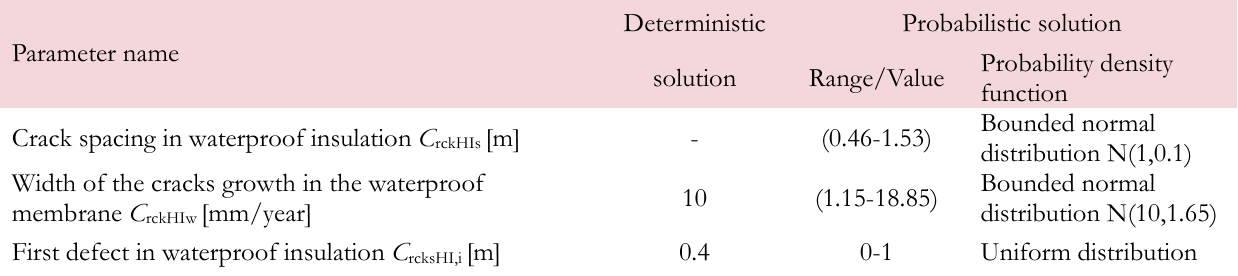
Table 2: The modification of random input variables and deterministic input parameters for ordinary concrete and a reinforced concrete bridge deck with a crack under damaged waterproof insulation (P2B - unprotected steel reinforcement, P2E - steel reinforcement protected by an epoxide coating). Other parameters of the model are given in Tab. 1.